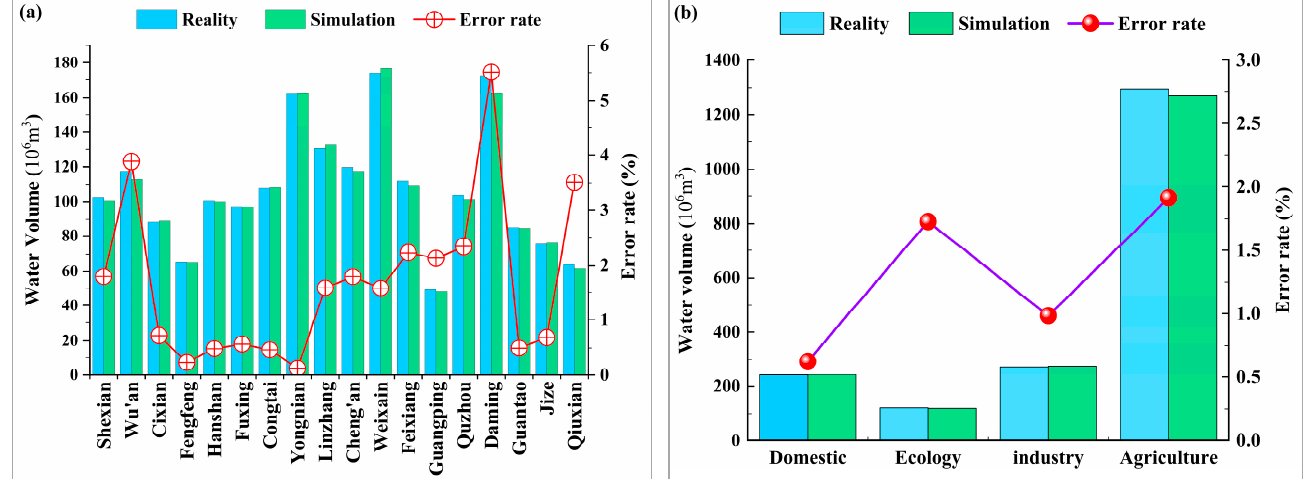
Figure 4. The comparative analysis of water supply between simulation and actual: ( a ) calculation units and ( b ) different industries.